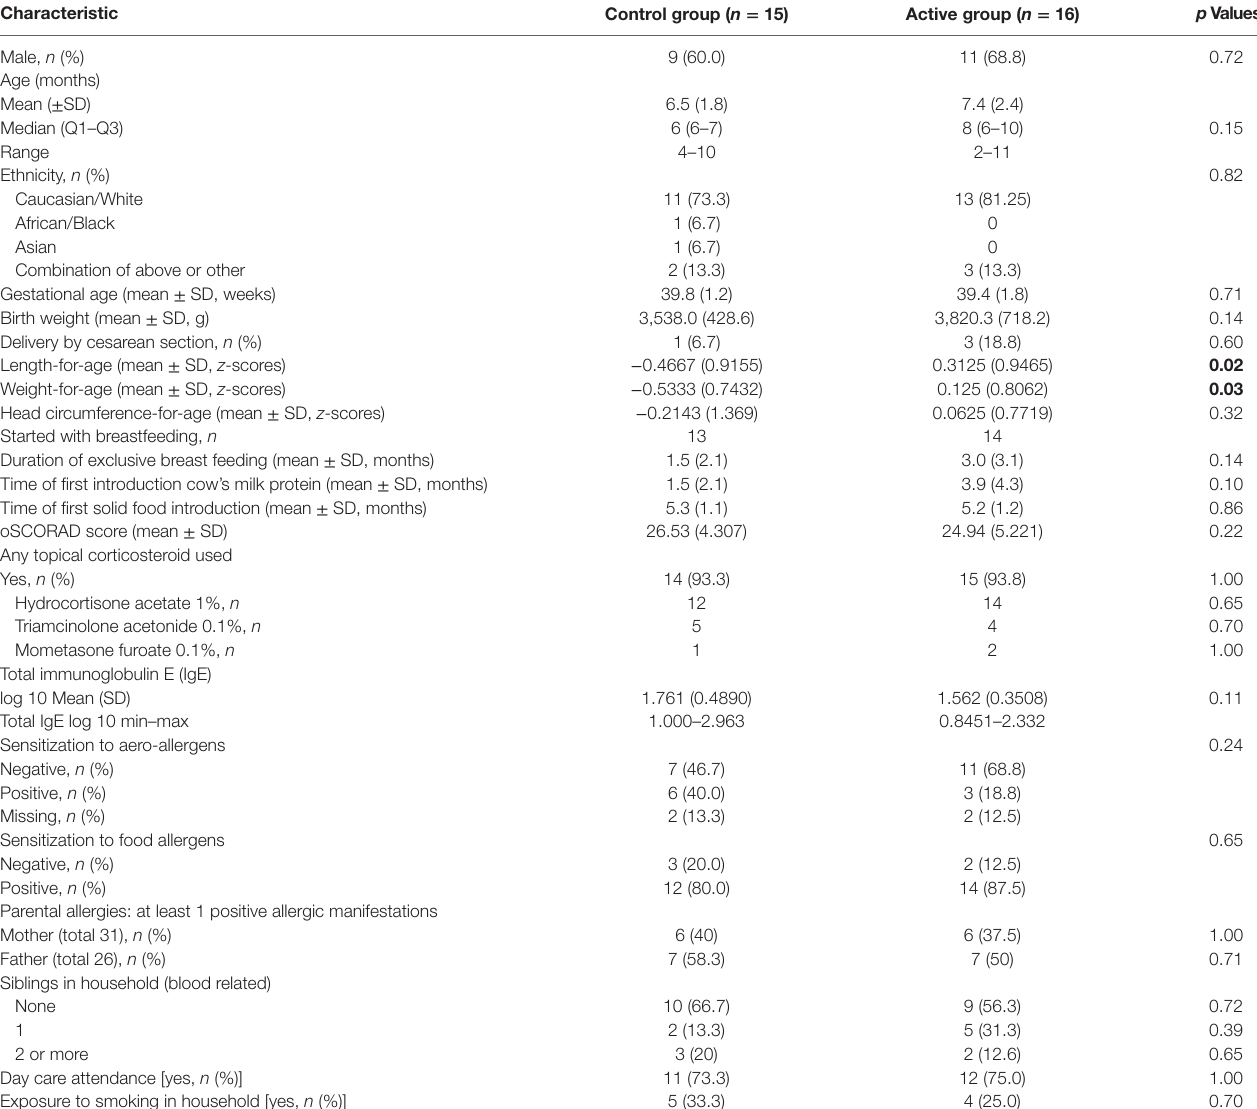
TaBle 1 | Baseline characteristics of the clinical study ( n = 31).